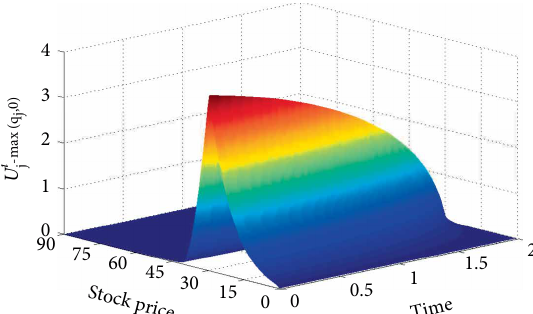
with 𝑟 = 0.05, 𝛾 = 0.06, 𝑈(𝑧,𝑡) − 𝑞(𝑧)